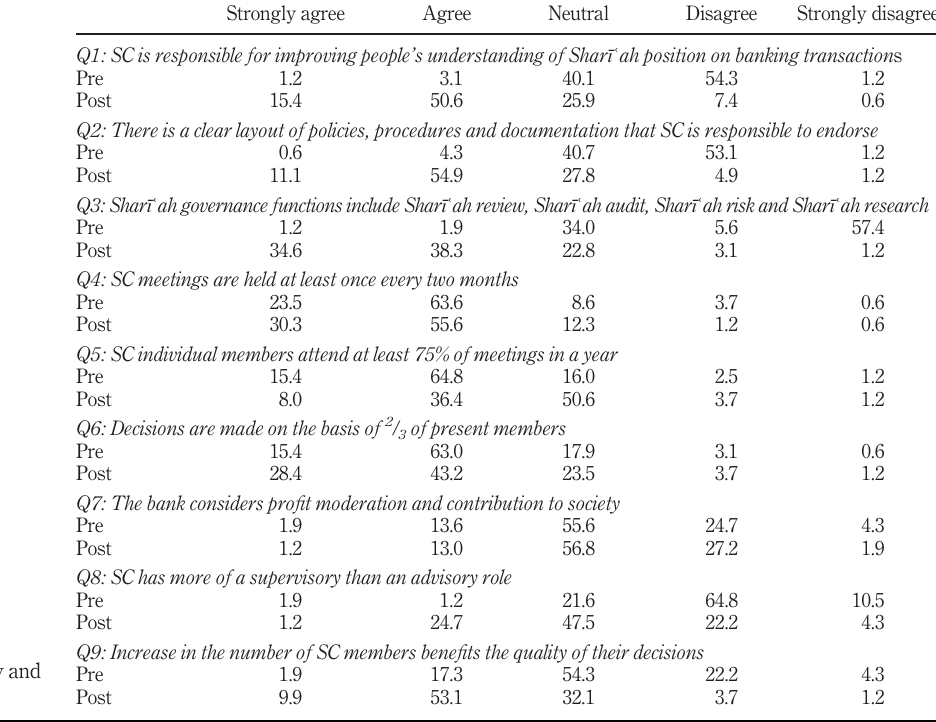
Strongly agree Agree Neutral Disagree Strongly